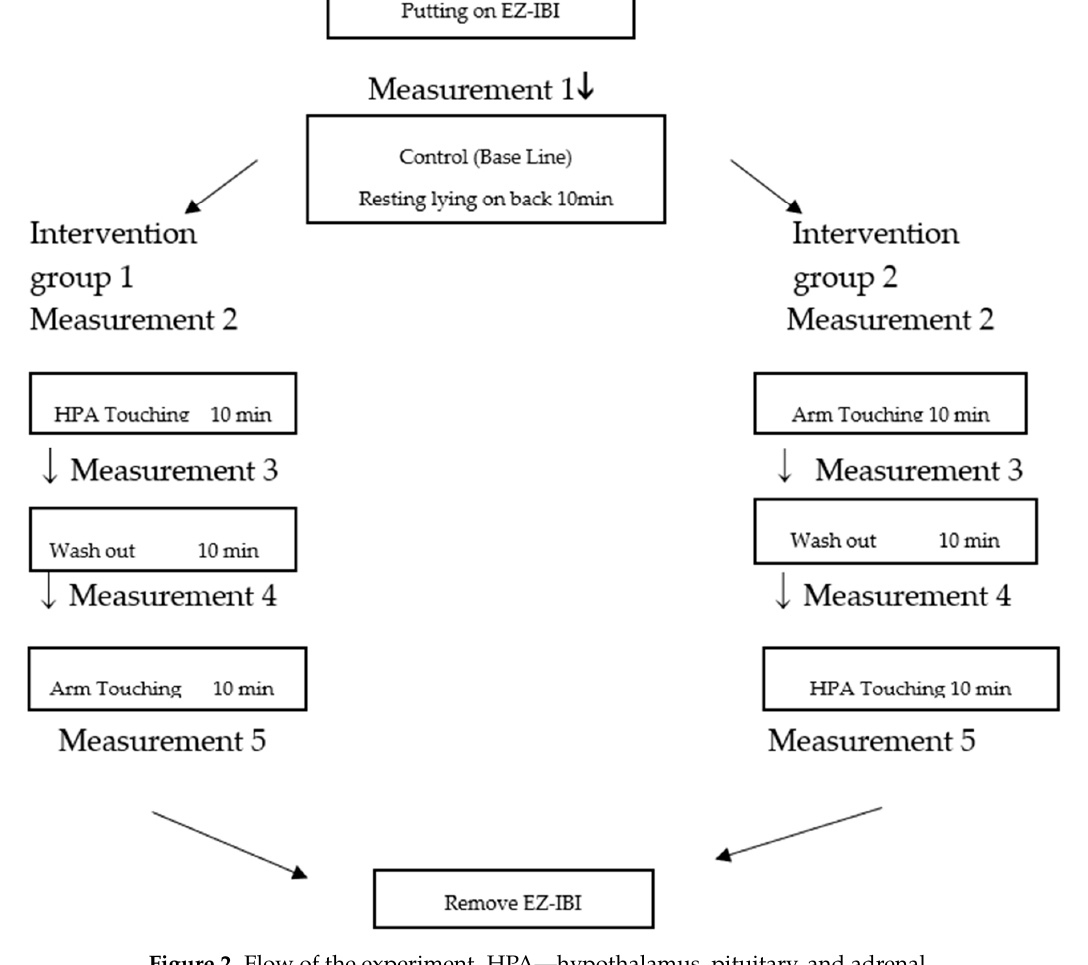
Figure 2. Flow of the experiment. HPA—hypothalamus, pituitary, and